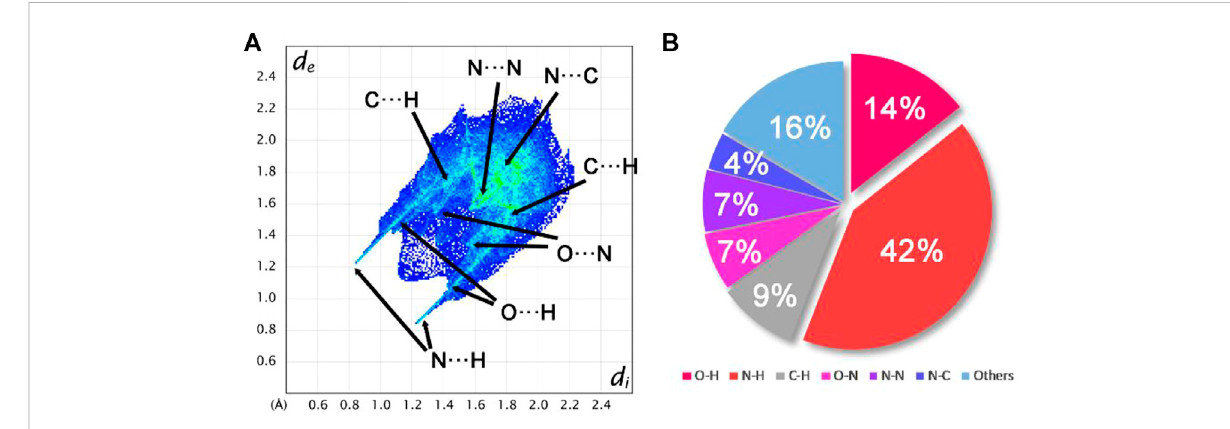
FIGURE 7 (A) 2D fi ngerprint plot for compound 6 . (B) Populations of the molecular contacts for compound 6